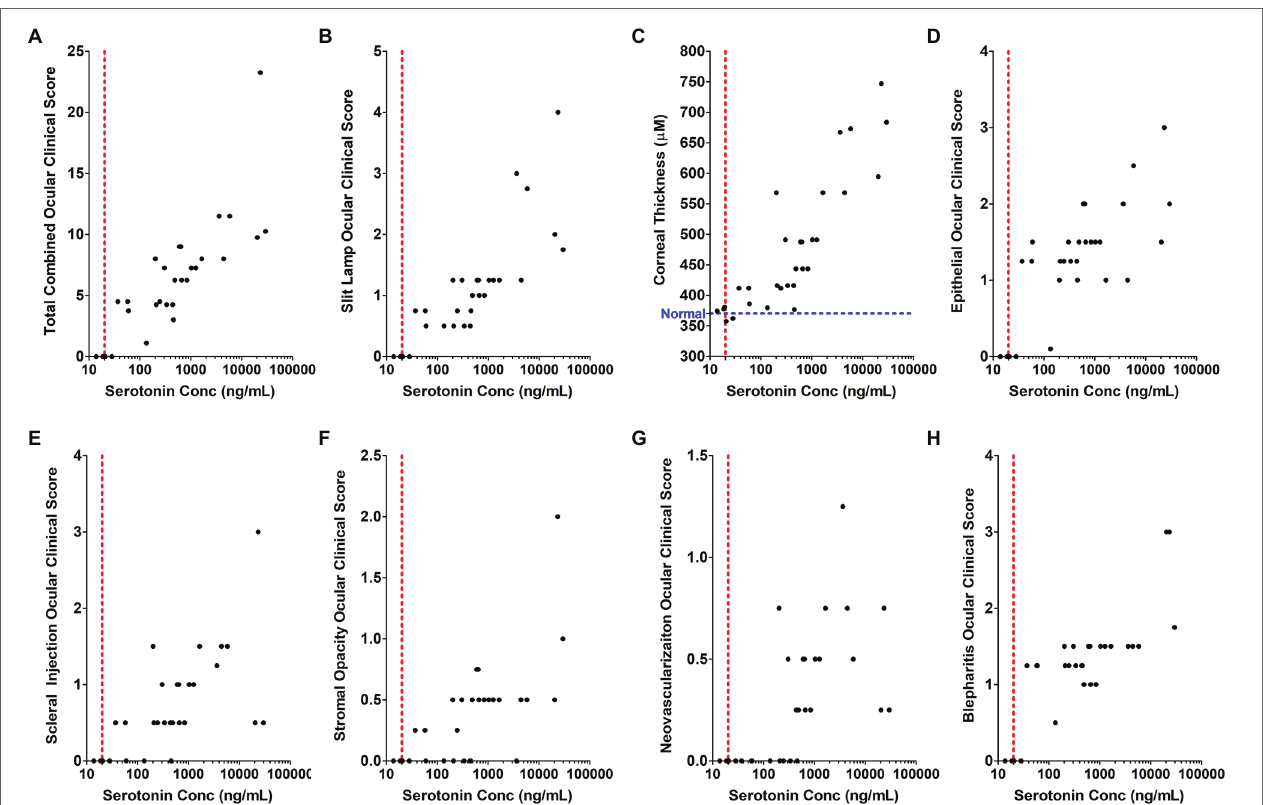
FIGURE 9 | The concentration of serotonin in the aqueous humor positively and significantly correlates with individual inflammation-associated ocular disease parameters in a rabbit eye model of acute herpetic keratitis. (A–H) Correlation analysis was performed comparing serotonin concentration in the AH of HSV-infected rabbit eyes relative to its corresponding clinical score for each of the indicated clinical assessment parameters. (A) Combined total clinical ocular scores; (B) Fluorescent slit lamp biomicroscopy; (C) Corneal thickness measured by Pachymeter (Blue line indicates the average normal thickness of an uninfected cornea); (D) Epithelial damage and inflammation; (E) Scleral injection; (F) Stromal opacity; (G) Corneal neovascularization; and (H) Blepharitis. The Spearman’s correlation coefficient (denoted by r ), which reflects the rank order correlation between the identified two variables, and the Pearson’s correlation coefficient (denoted by r ), which measures the strength of the linear relationship between the two variables are indicated within Table 1 with the corresponding significance of those associations ( p value, p